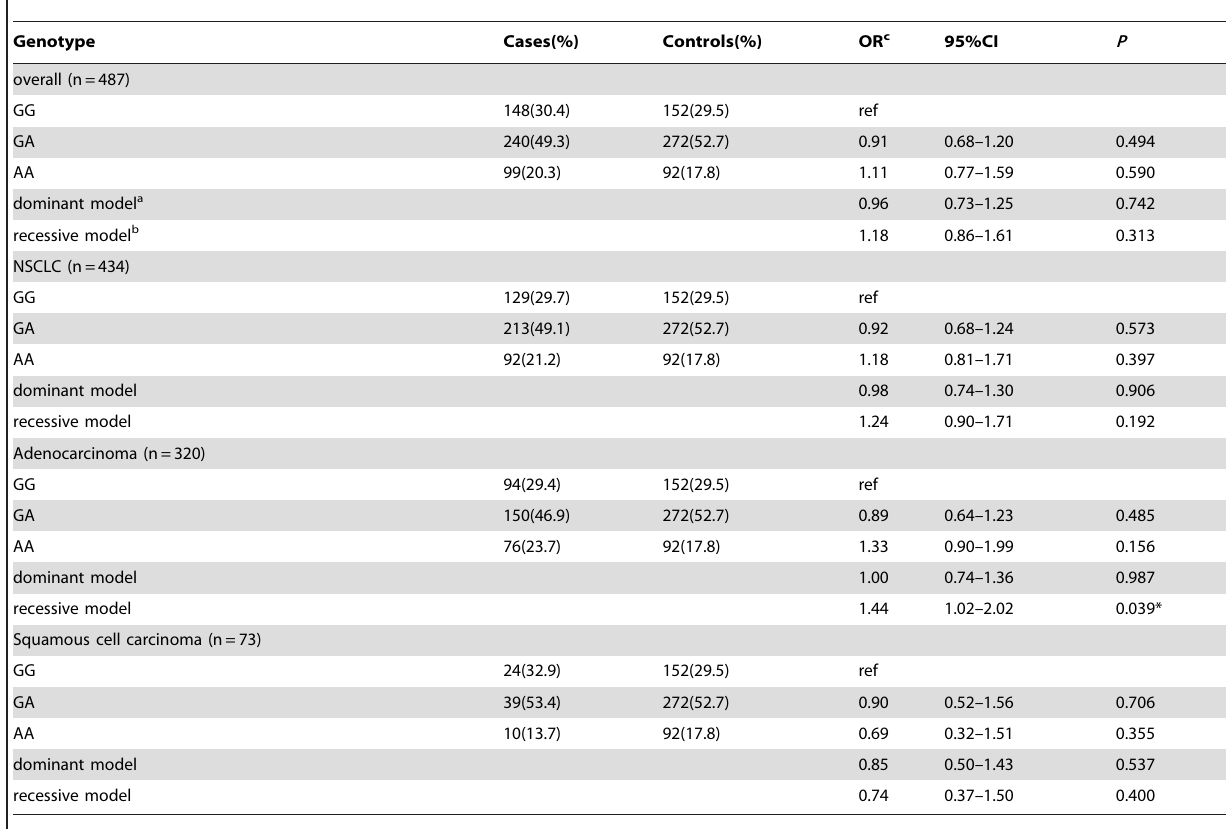
Table 2. Distribution of ATM rs189037 genotypes and ORs for lung cancer cases and controls.